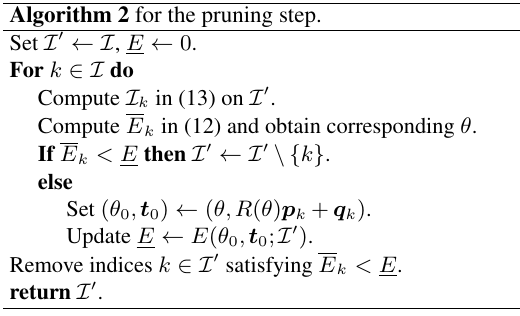
Algorithm 2 for the pruning step.